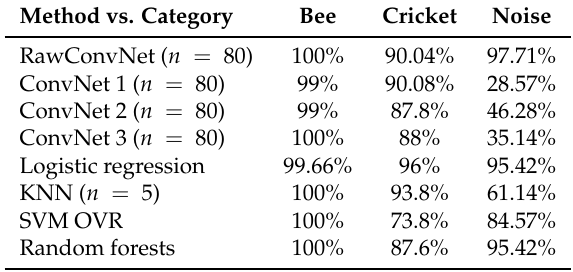
Table 24. Classification accuracy summary on BUZZ1 validation dataset by category.